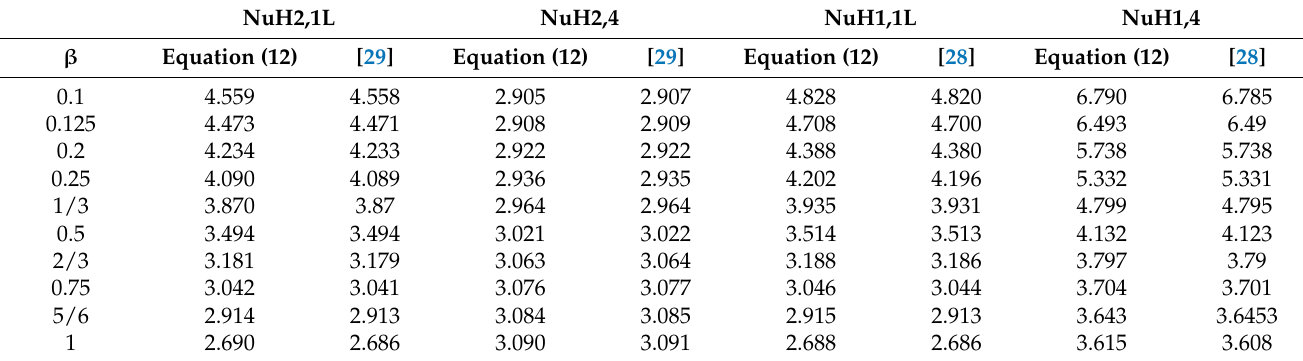
Table 2. Comparison between present results (i.e., Equation (12)) and data available in the literature.